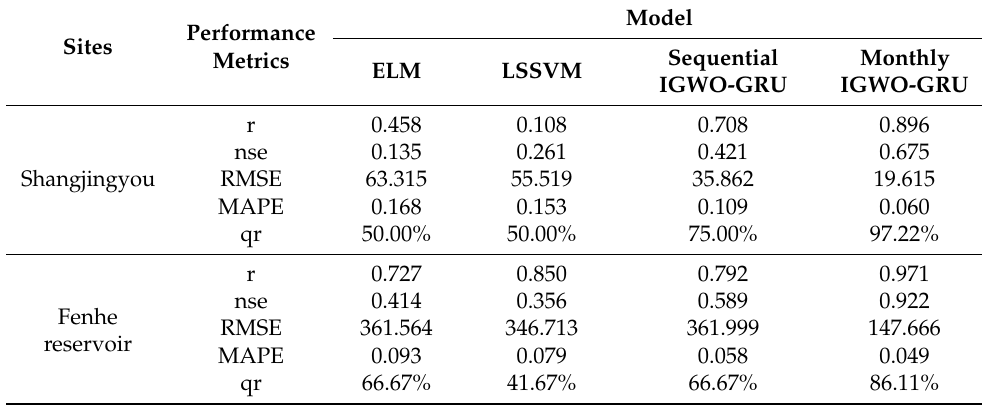
Table 3. Performance evaluation of the compared models applied in the forecasting of streamflow series in the validation period based on three evaluation